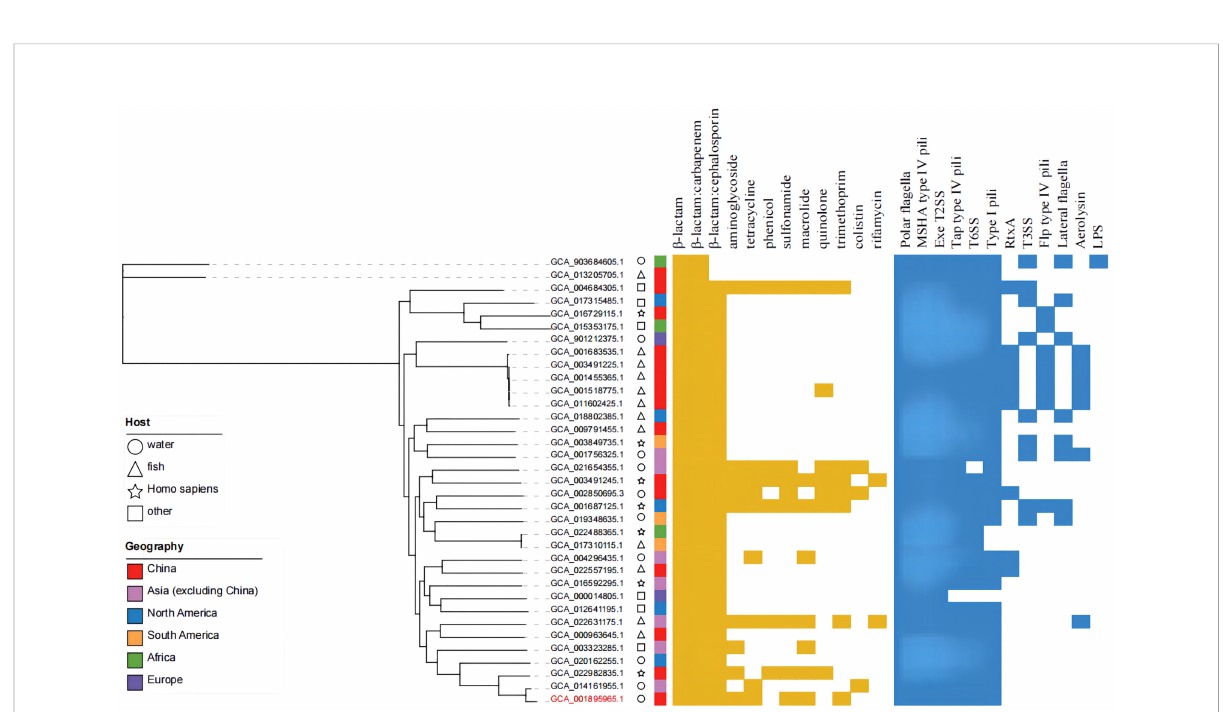
FIGURE 8 Phylogenetic tree, distribution of drug-resistance genes and virulence factors of 35 strains of A. hydrophila